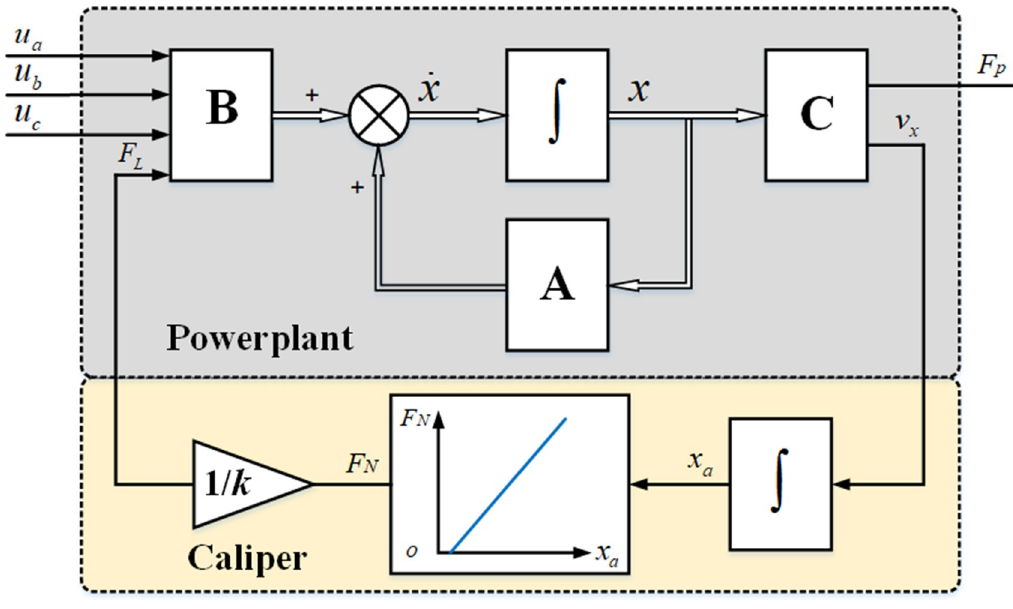
Fig 3. EMB system model.